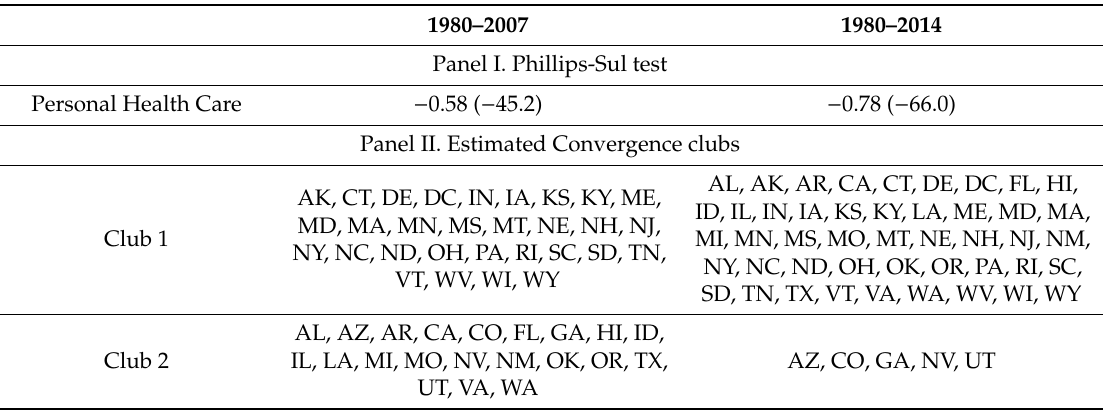
Table 1. Testing for